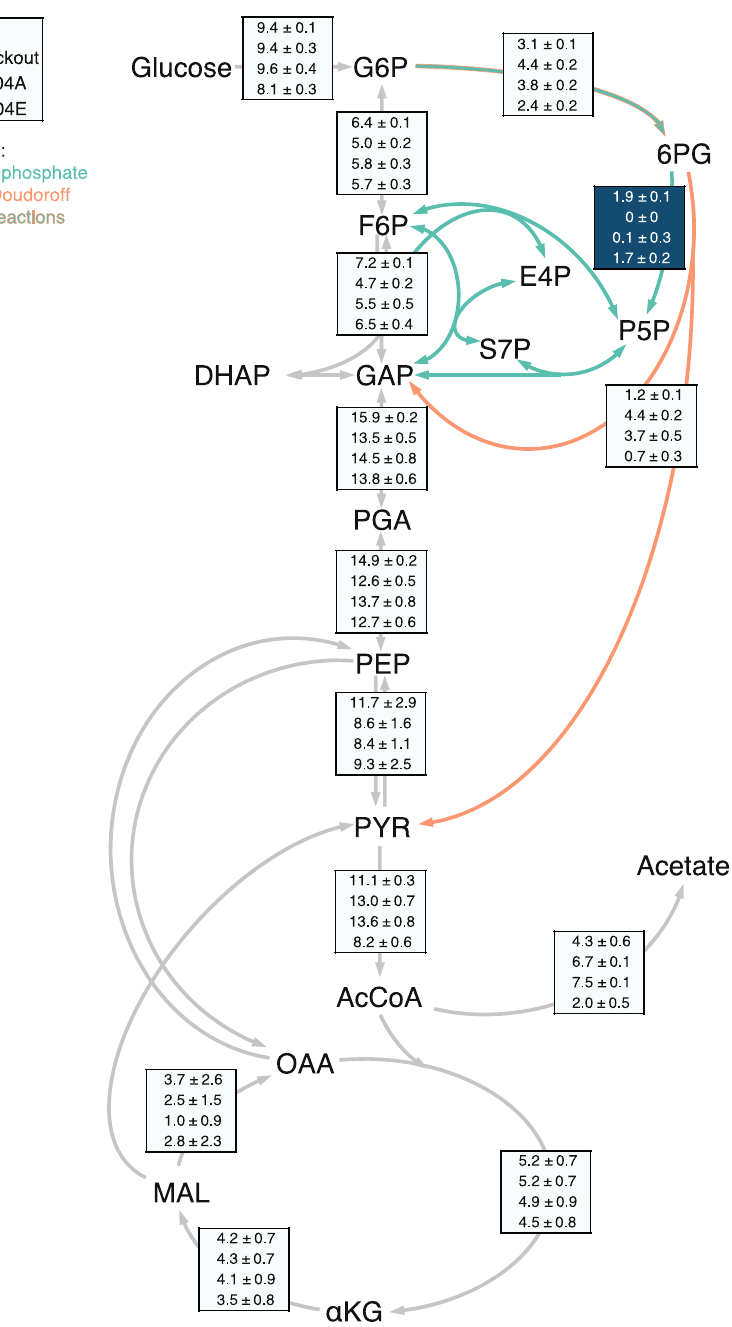
Fig. 4 Absolute intracellular fl uxes in Gnd knockout and phosphomutants. 13 C-based fl ux map of the wild-type ( fi rst), gnd knockout (second), phosphoabolishing gnd S304A (third), and phosphomimetic gnd S304E (fourth) mutants during exponential growth on glucose. Flux through the Gnd- catalyzed reaction is highlighted in dark blue. Flux values are given in mmolg CDW − 1 h − 1 . Source data are provided as a Source Data fi